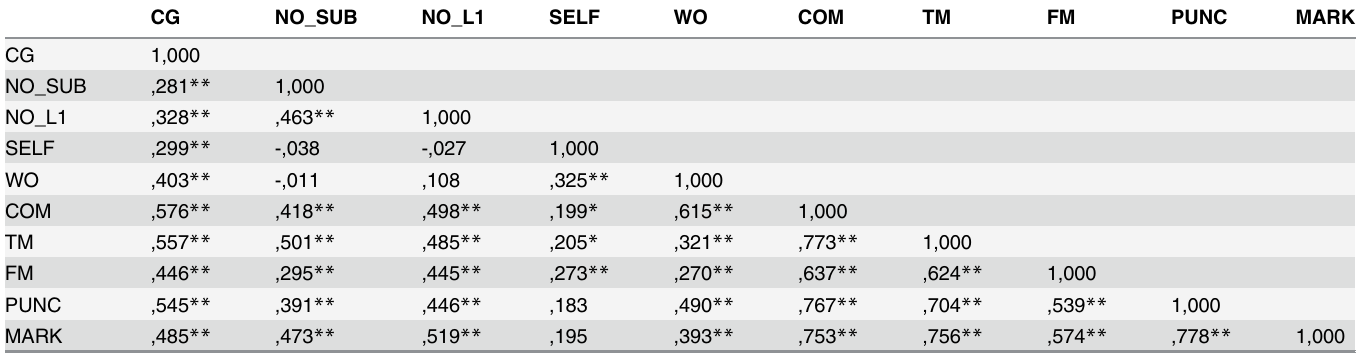
Table 4. Inter-element relationship